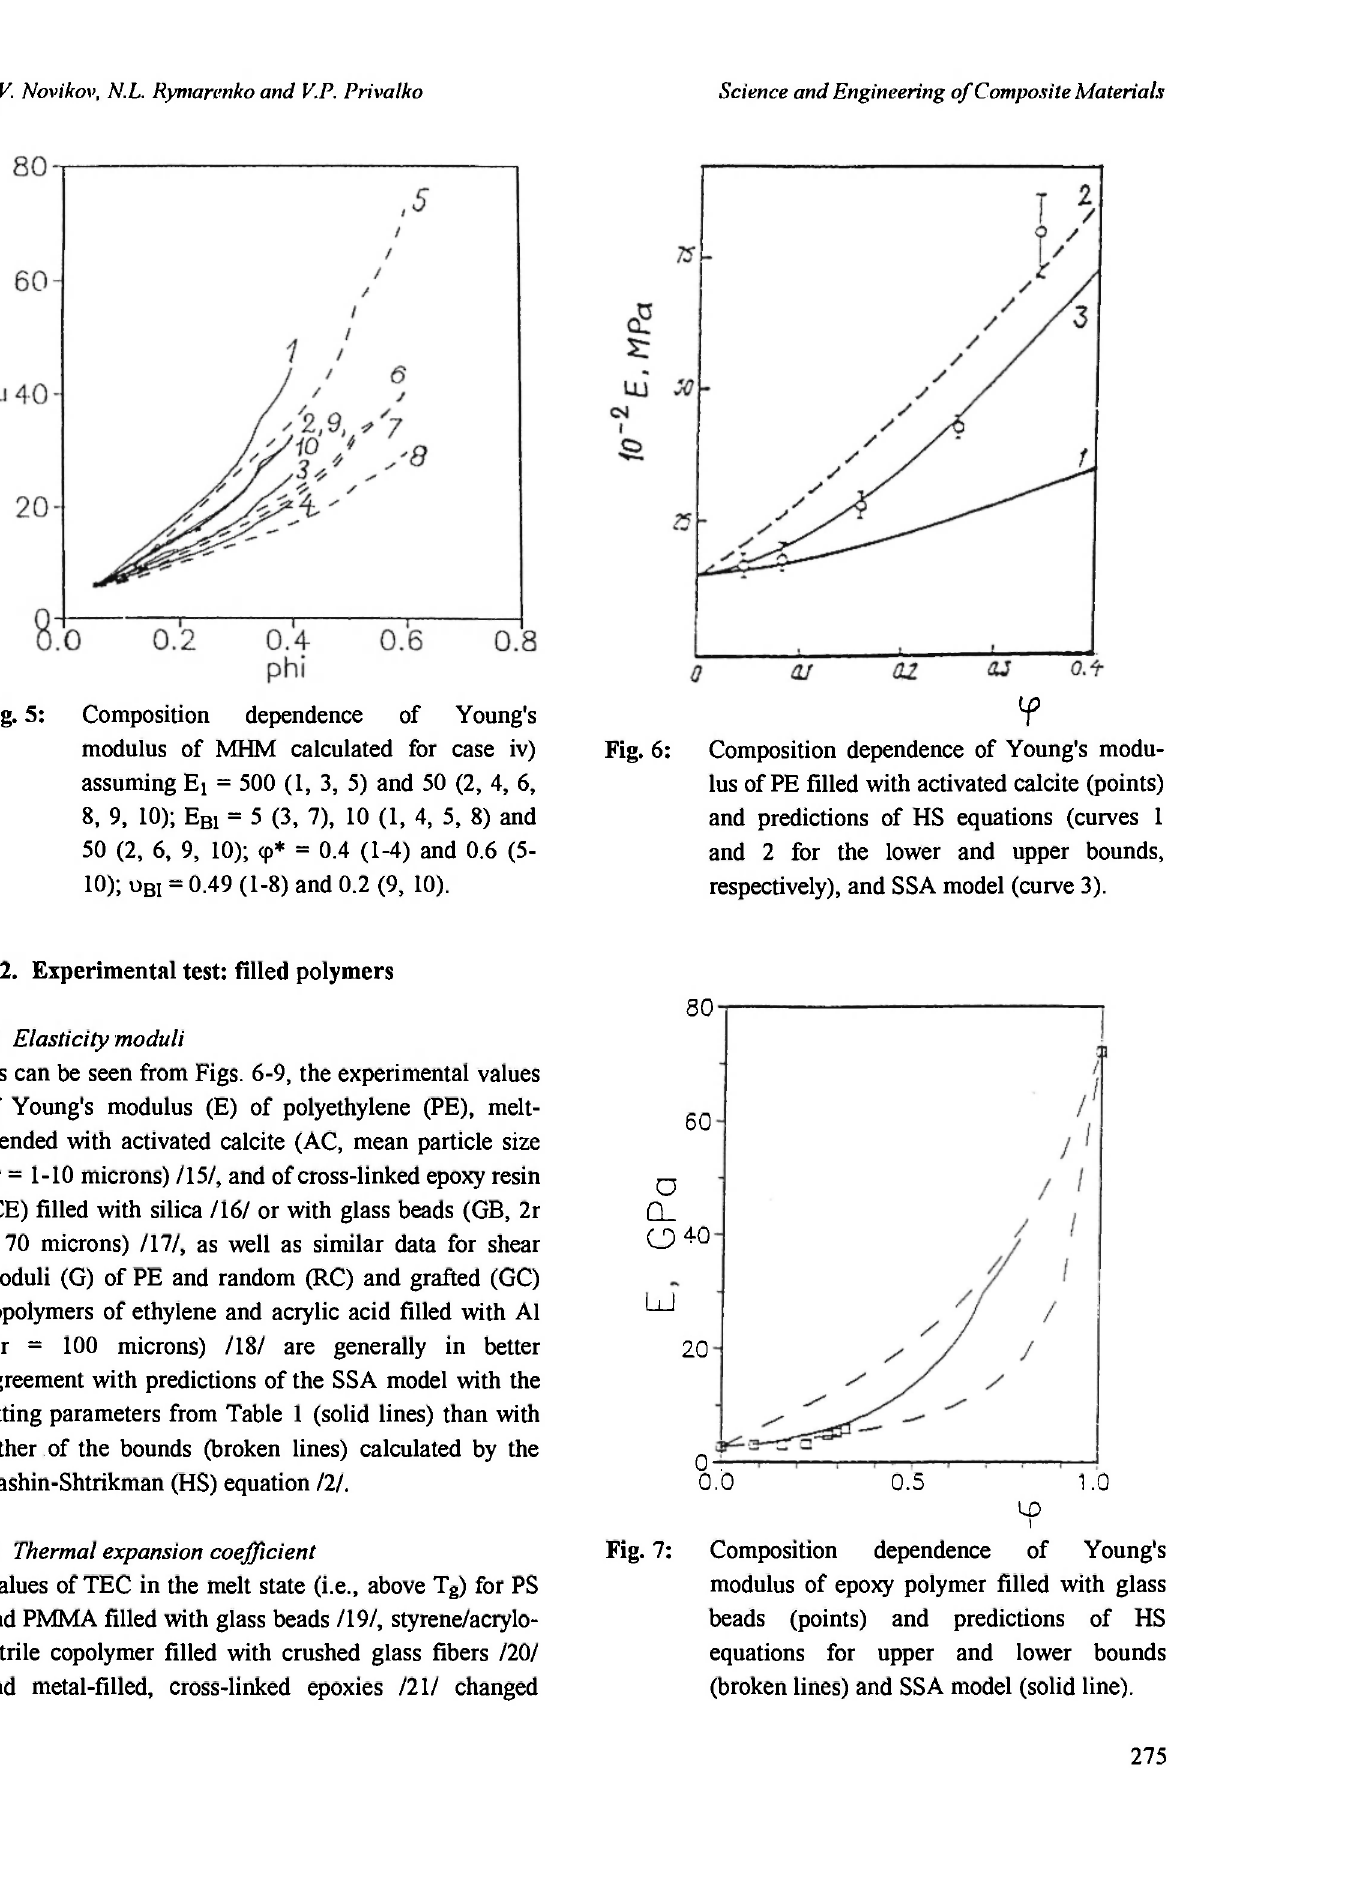
Fig. 7: Composition dependence of Young's modulus of epoxy polymer filled with glass beads (points) and predictions of HS equations for upper and lower bounds (broken lines) and SSA model (solid line).